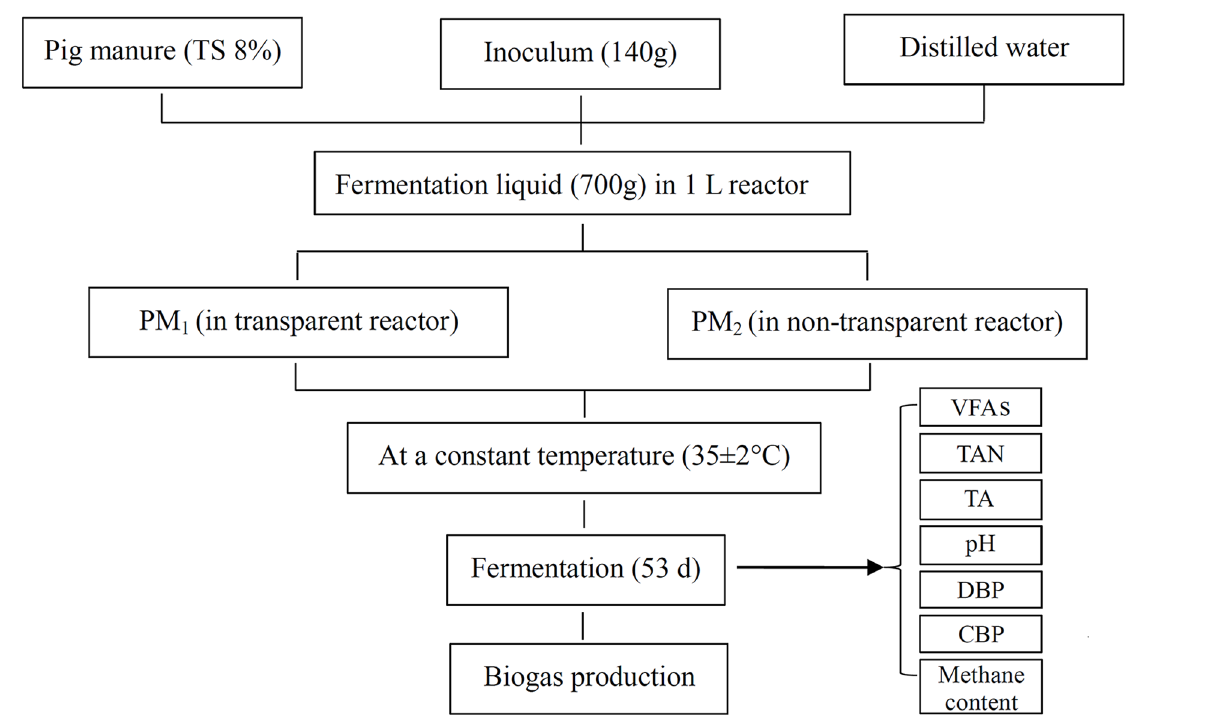
Fig 1. Flowchart of experiment including raw material, the experimental conditions and method.